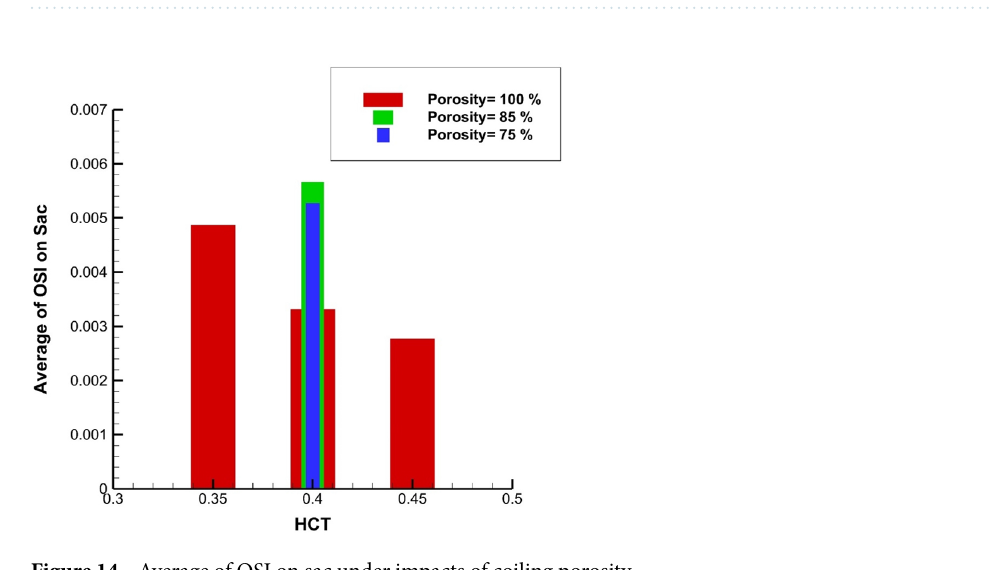
Figure 14. Average of OSI on sac under impacts of coiling porosity.